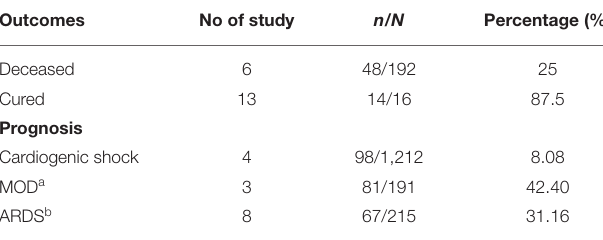
TABLE 2 | The outcomes and prognosis of